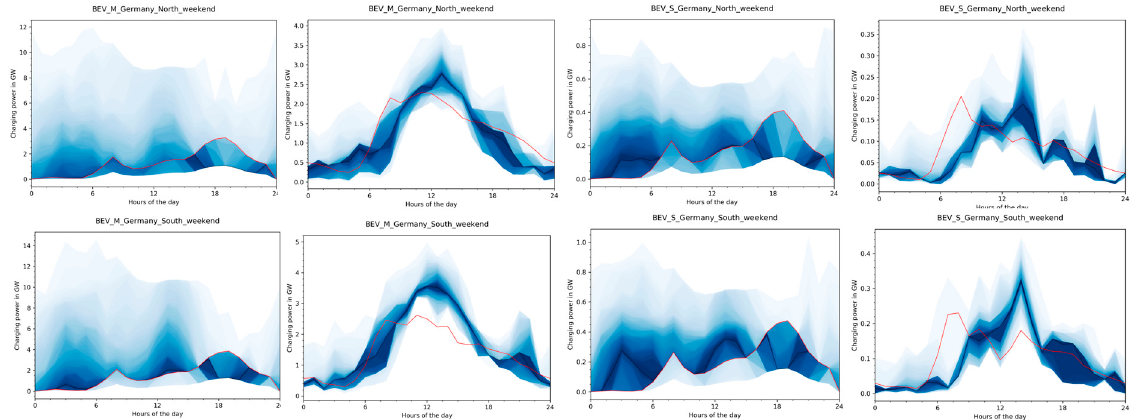
Figure A8. Daily probability distributions for total charging (controlled and uncontrolled) of medium and small sized BEV fleets in Northern Germany ( top row ) and Southern Germany ( bottom row ) on weekends. The first and the third column show S1 results and the second and third column show S2 results. A case of completely uncontrolled charging is shown as red line.